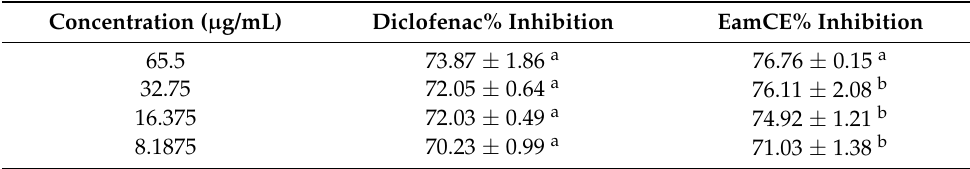
Table 6. Heat induced hemolysis (percentage inhibition of hemolysis).